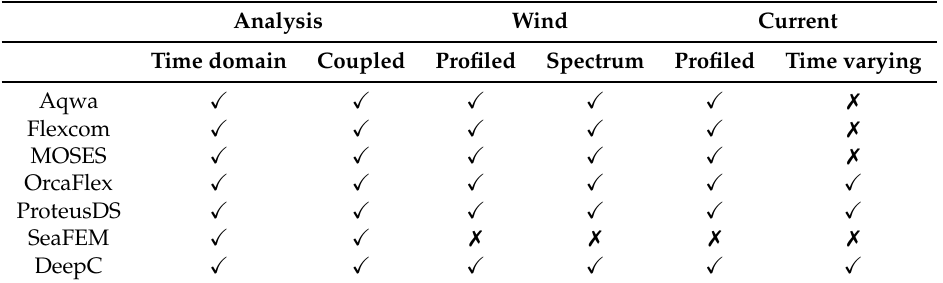
Table 2. Comparison of software capabilities concerning analysis type and ability to model wind and current. (cid:88) and (cid:55) denote respectively that the capability is available or unavailable.